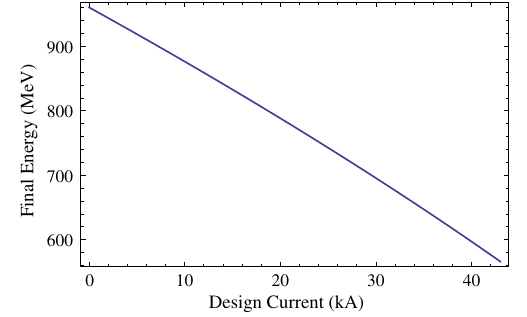
FIG. 11. Final resonant energy versus design beam current for a compensated undulator.